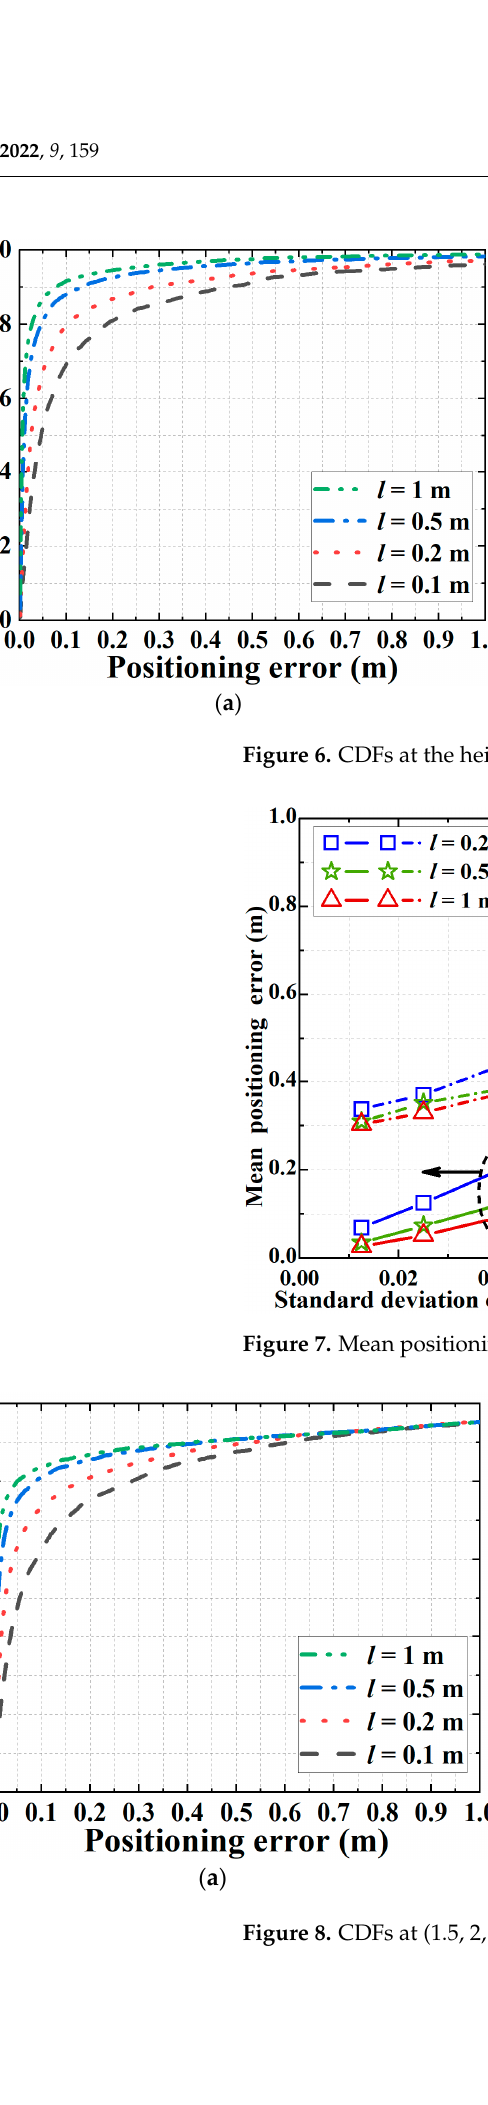
( b ) Figure 8. CDFs at (1.5, 2, 1) for: ( a ) 3D positioning errors; and ( b ) azimuthal errors. ( θ = 30°). By using the same the simulated conditions as in Figure 8a, Figure 8b plots the sim- ulated CDFs of the azimuthal errors. We see that when l is 0.1 m, 0.2 m, 0.5 m and 1 m, the probability of achieving azimuthal errors less than 5° is 89.5%, 93.1%, 95.2%, and 95.3%, respectively, thus proving the high orienteering accuracy of the proposed VLPO scheme for a tilted receiver. Furthermore, increasing the interval between PDs can enhance the orienteering accuracy effectively. For example, by increasing l from 0.1 m to 0.5 m, the probability of achieving azimuthal errors less than 3° can be improved from 79.4% to 93.4%, when θ = 30°.